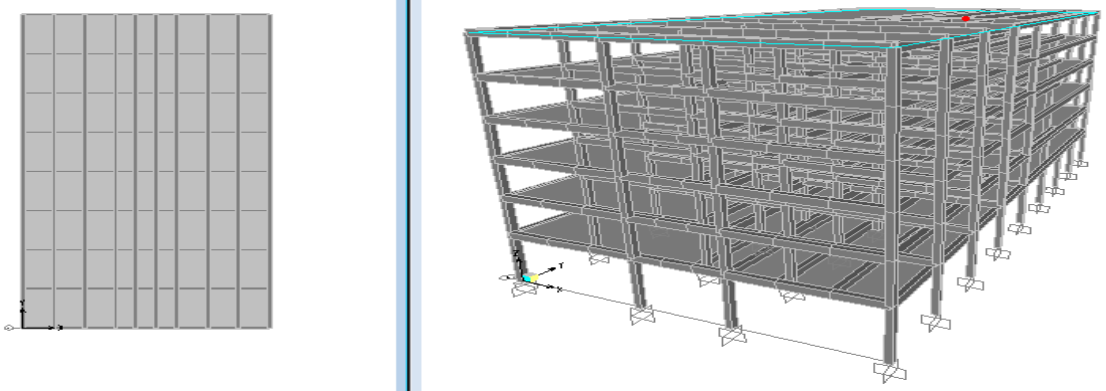
Figure 2. Plan and 3D views of the 6-story model in ETABS.